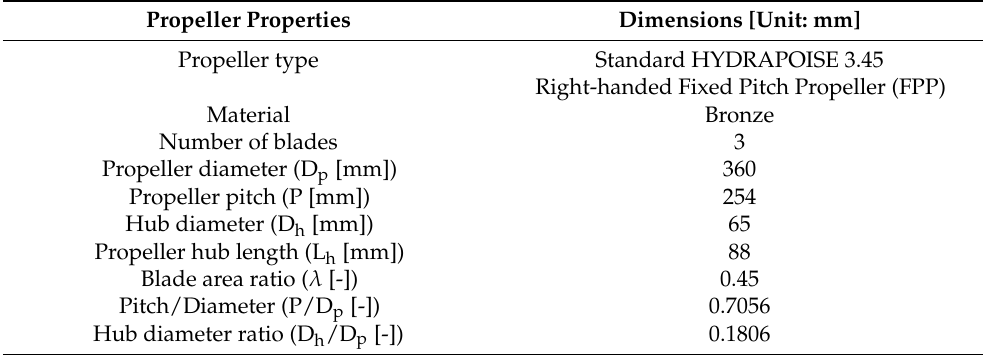
Figure 3. ( a ) Rope cutter dimensions; ( b ) assembled rope cutter geometry; ( c ) detached rope cutter geometry. Table 1. Principle propeller properties.